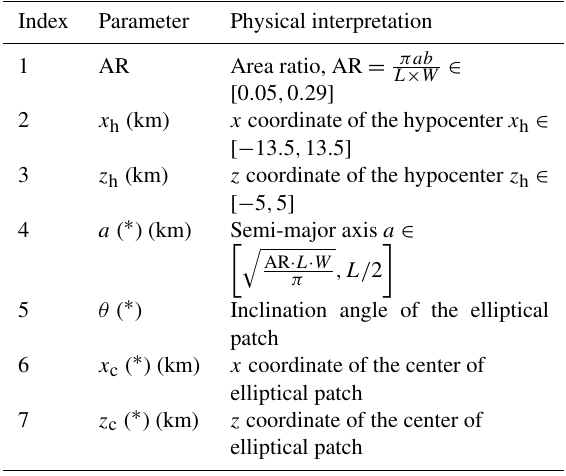
Table 2. Parameters governing fault plane